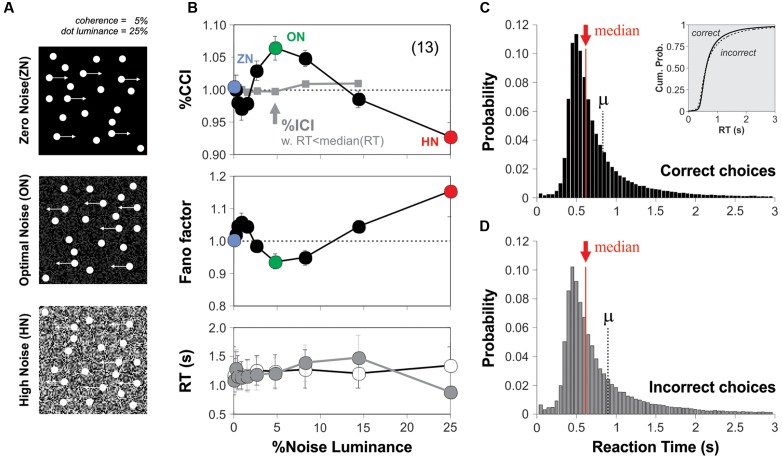
Background noise enhances motion detection in the RDM task.
(A) Cartoon of the RDM task with different background noise average luminance levels [zero noise (ZN): 0% luminance; optimal noise (ON): 5% luminance; high noise (HN): 25% luminance]. The noise source was dynamic; it was refreshed every frame and was added as a background behind the RDM dots. (B) Group-averaged %correct choice index (upper panel; %CCI = %correct choices with noise/% correct choices without noise; paired trials, see Materials and Methods) against the luminance of background noise (coherence of 5%; stimulus luminance of 25%). No modulation in %incorrect choice index (%ICI) for incorrect choices that had RTs lower than the median RT (i.e., median split; gray squares in B). The Fano factor of the %CCI data presents a local minimum with optimal background noise (green dot; middle panel). The increase in %CCI around 5% of noise luminance (green dot in the upper panel) cannot be explained by changes in the averaged RTs of the choices made in the presence (gray circles) vs. the absence (empty circles) of background noise (middle panel). The skeweed RT distributions for correct (C) and incorrect (D) choices had similar shapes, means and medians. Number of subjects in parenthesis.